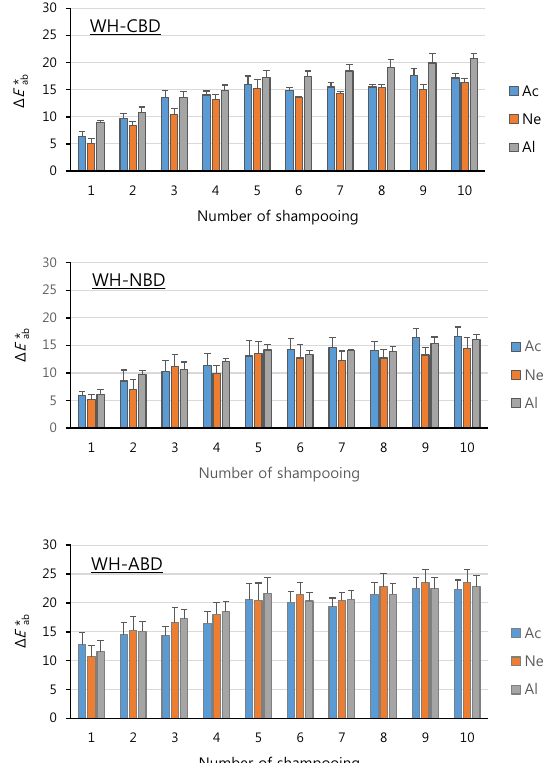
Fig. 4 Color difference (Δ E * ab ) of white hair (WH) dyed with three types of basic hair dye after shampooing using Acidic, Neutral, and Alkaline